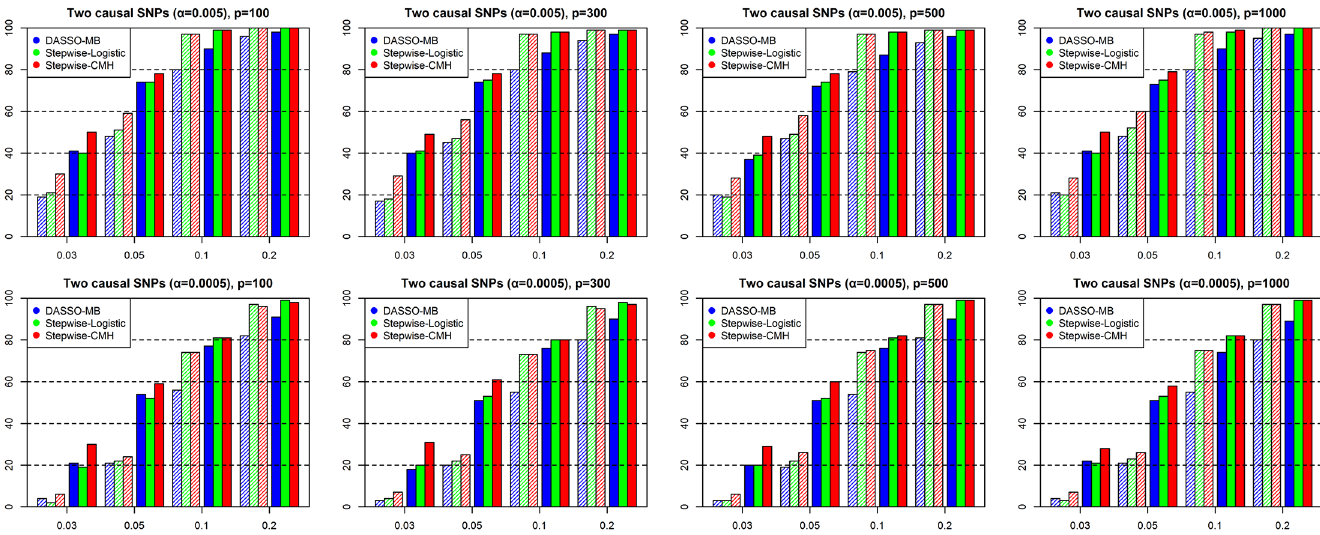
Fig 2. Performance comparison of stepwise CMH method, stepwise logistic and DASSO-MB methods for the codominant model with two causal SNPs. Blue bars represent the result of the DASSO-MB method, green bars represent the result of the stepwise logistic method, and red bars represent the result of the stepwise CMH method. Bars with diagonal lines are the results of power and solid bars are those of Dprob. The x-axis represents the MAF of true causal SNPs and the y-axis represents the value of two accuracy measures based on three approaches.